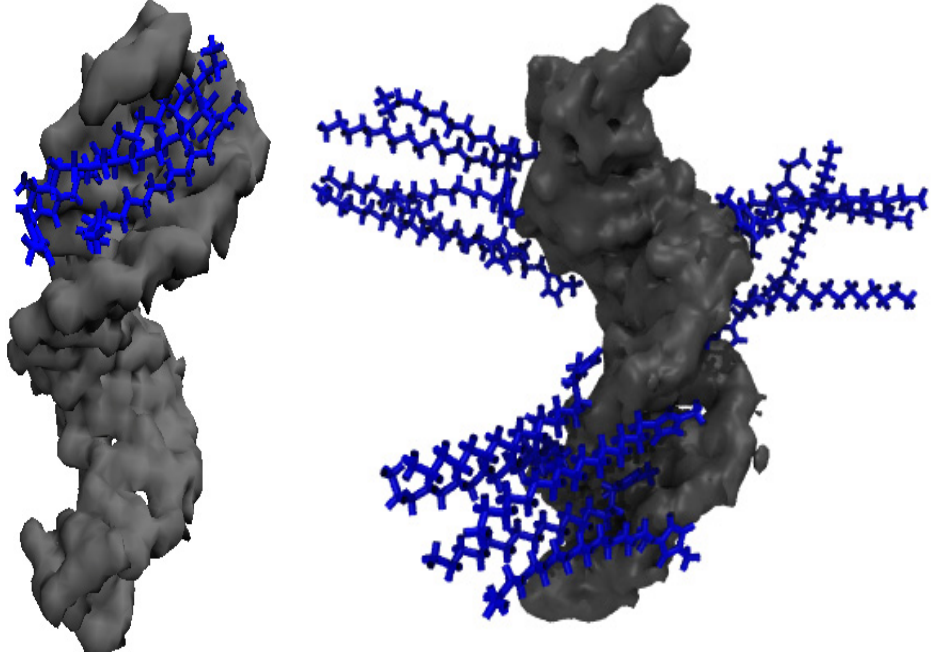
Figure 8. ( Left image ): The distribution of [Im 16,1 ] + cations (blue color) that shows the association with DNA duplex (gray) minor grooves in the aqueous solution. IL concentration is 20 mM. ( Right image ): The distribution of [Im 16,1 ] + cations for the association with the DNA duplex surface in the aqueous solution at 500 mM.